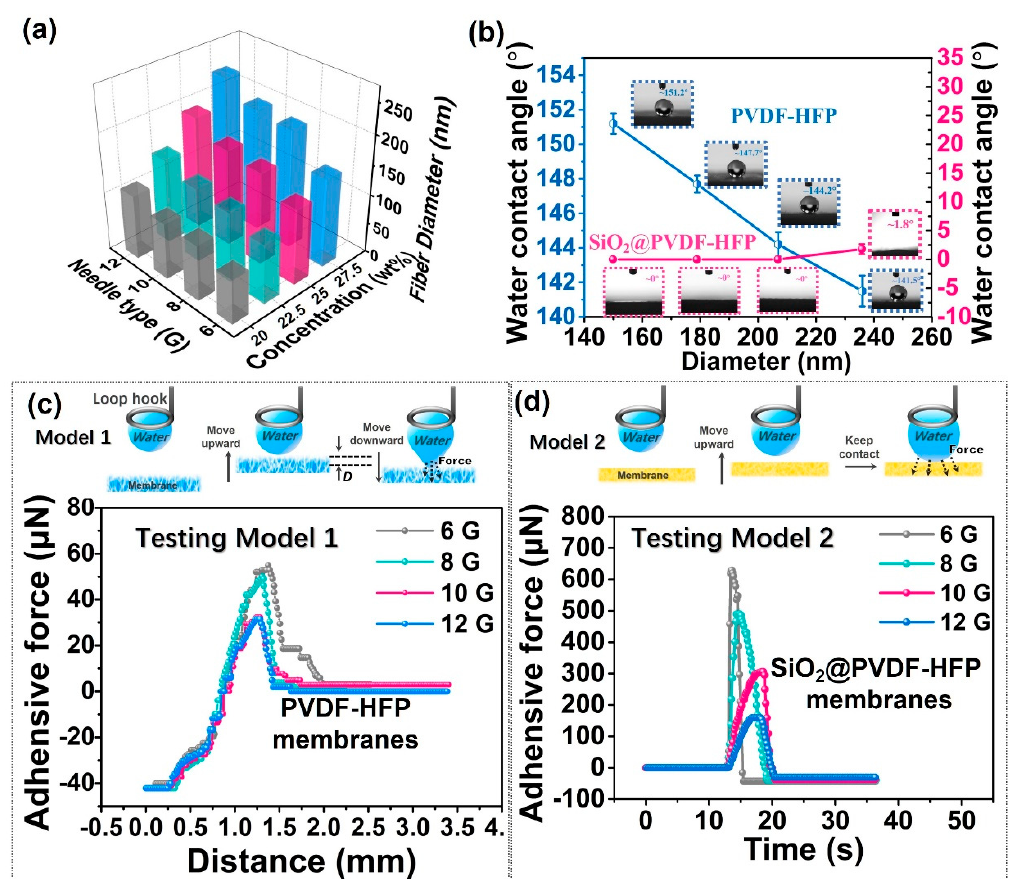
Figure 3. ( a ) The relationship between needle type, concentrations of electrospun solution, and fiber diameter. ( b ) Water contact angles of PVDF-HFP-6G, -8G, -10G, -12G and SiO 2 -PVDF-HFP-6G, -8G, - 10G and -12G. ( c ) Water droplet (5 μ L) was brought to contact the membrane and then pulled off. It enabled to probe the interaction between water droplet and membrane. Top: schematic illustration of testing model 1. ( d ) Water droplet was brought to contact the membrane without pulling off. The real- time force change was recorded. Top: schematic illustration of testing model 2.